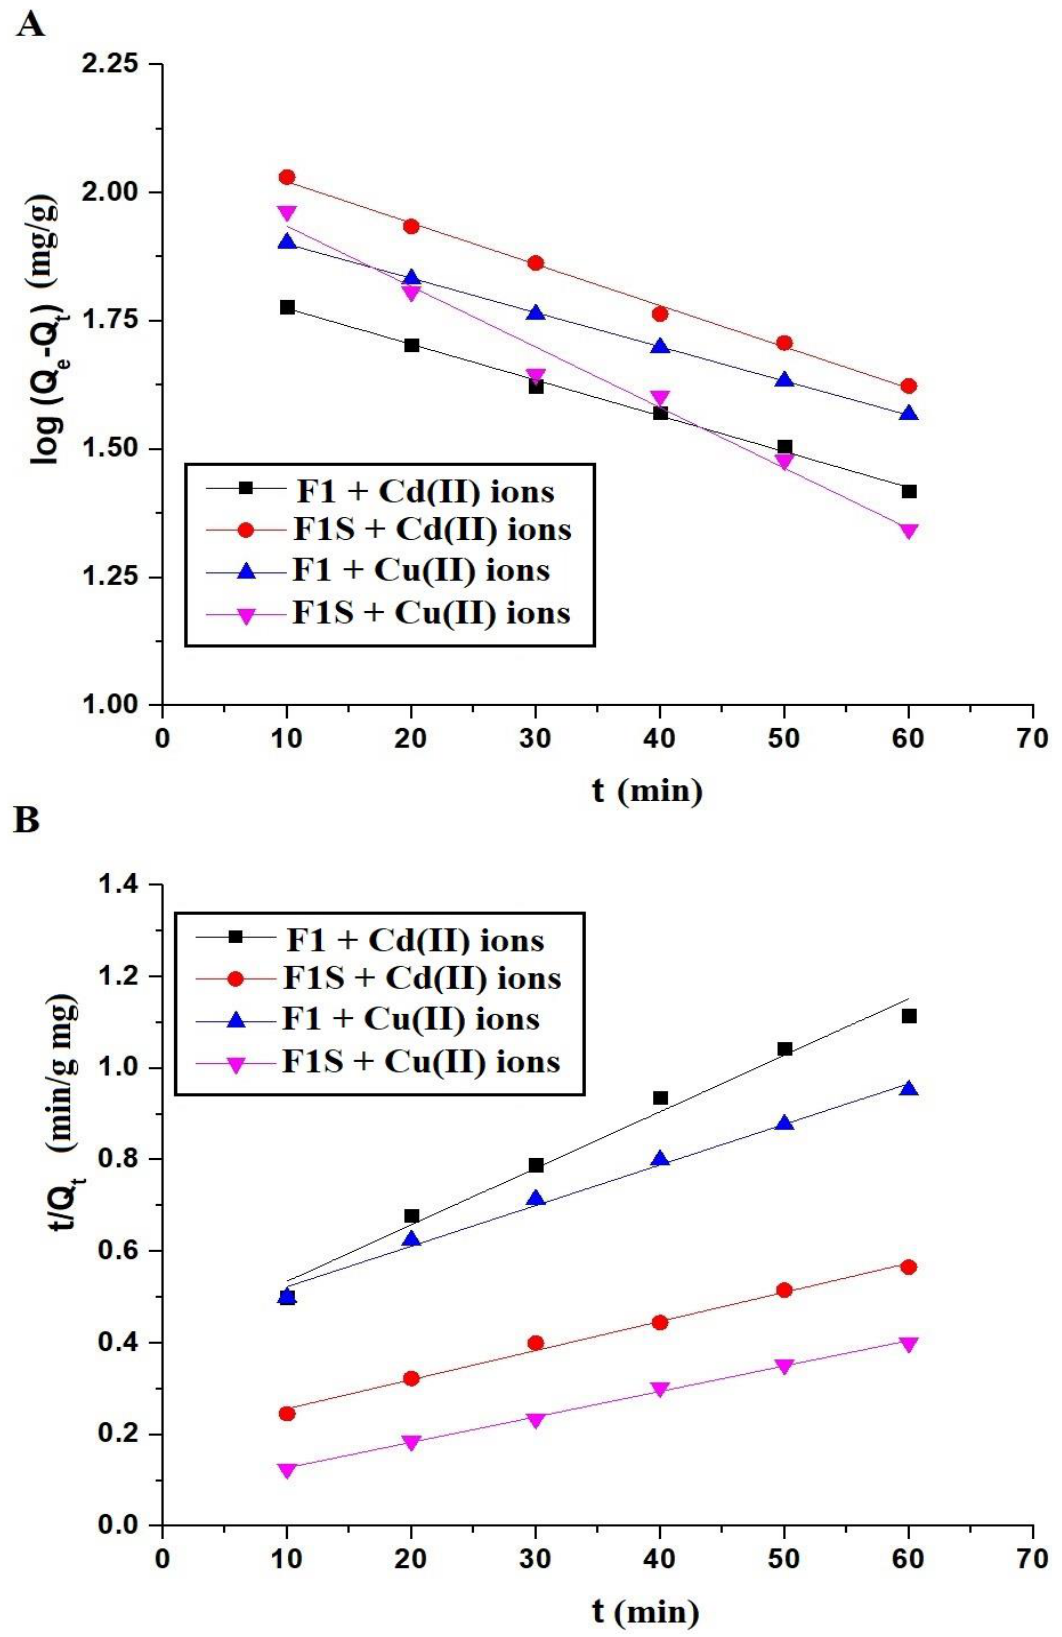
Figure 8. The plots of log ( Q e − Q t ) ( A ) and t / Q t ( B ) versus t for the removal of copper and cadmium ions using the F1 and F1S samples.